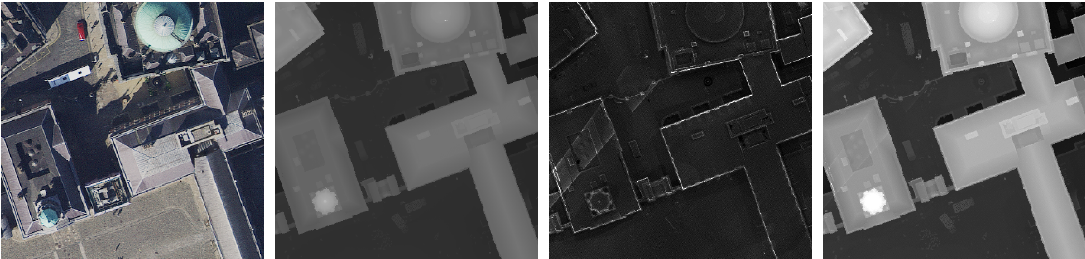
Figure 4. From left to right : optical imagery, DSM, return-pulse intensity, and fusion of DSM and return-pulse intensity. The optical image and the DSM are used in Mutual Information (MI) registration process whereas the fusion and the optical image are used in Hough validation. Both DSM and return-pulse intensity are derived from the point cloud